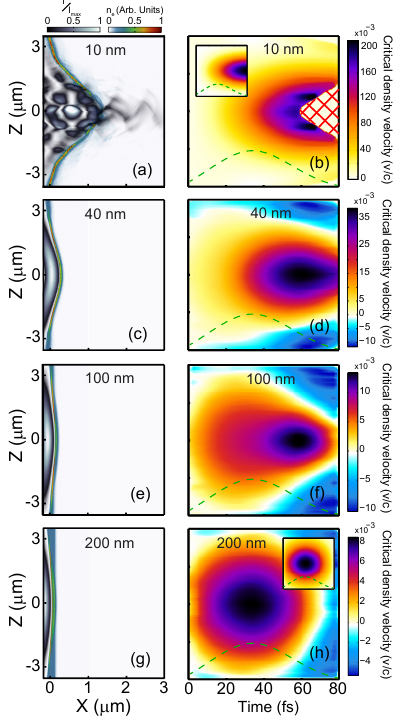
Figure 3. ( a ) Combined 2D plot of electron density and laser intensity, from a 2D particle-in-cell (PIC) simulation with l = 10 nm, at the time step corresponding to the moment that the target becomes relativistically transparent; ( b ) 2D PIC simulation of the plasma critical density surface (PCDS) velocity as a function of time and position along the Z-axis, again for l = 10 nm. The red shaded region corresponds to the parameter range for which the target has become relativistically underdense and therefore the PCDS no longer exists. The green dashed curve is the laser pulse intensity profile as a function of time, for reference. Corresponding plots for: ( c , d ) l = 40 nm; ( e , f ) l = 100 nm; and ( g , h ) l = 200 nm. Insets in ( b ) and ( h ) show the relativistic critical density velocity as a function of time and position as calculated using the LS and HB models, respectively (for a Gaussian laser temporal